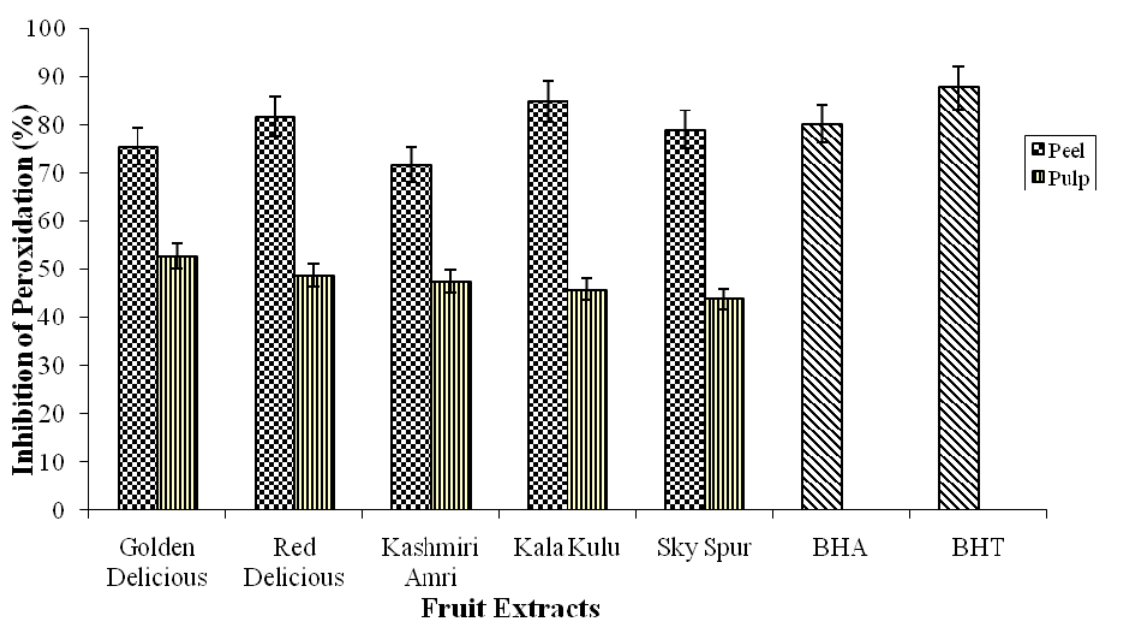
Figure 2. Antioxidant activity of 80% methanolic extracts of peel and pulp from different cultivars of apple ( Malus domestica Borkh.)